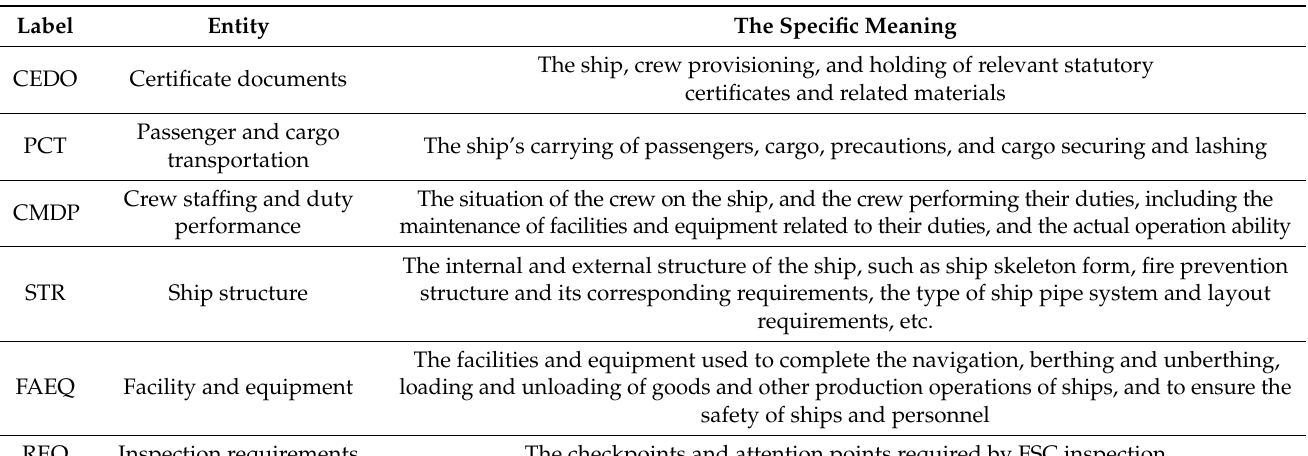
Table 4. Six types of entities and their specific